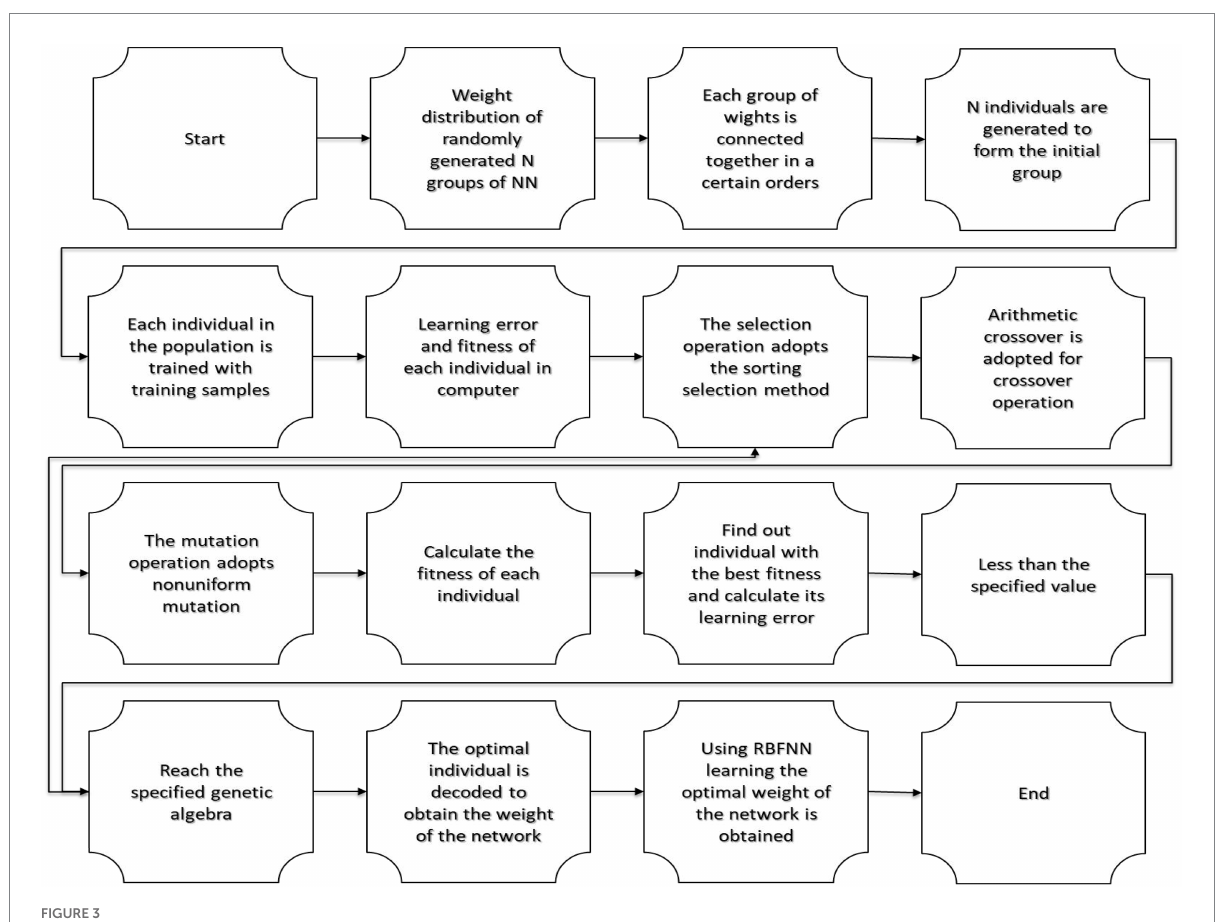
FIGURE 3 Schematic diagram of RBFNN-GA algorithm.